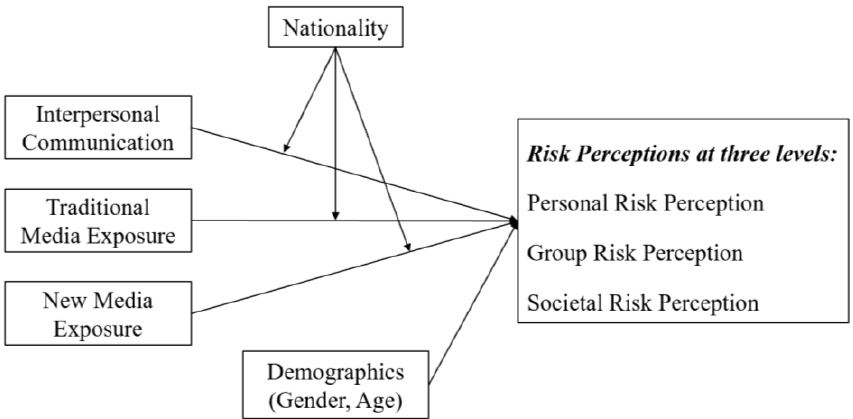
Figure 1. Conceptual model of national differences in the influence of communication factors on risk perceptions.